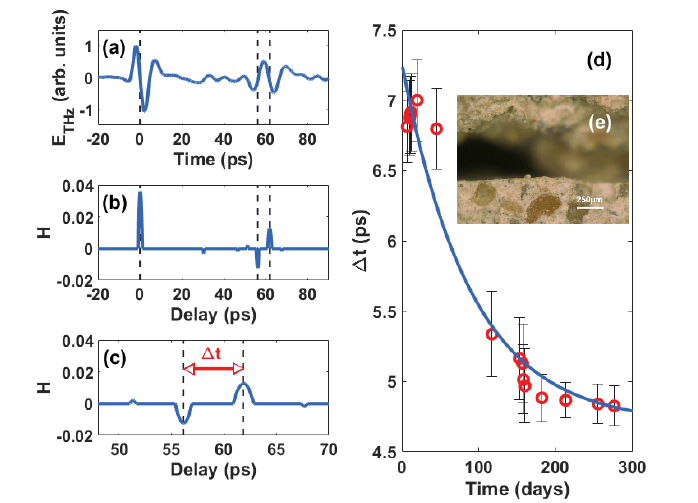
Figure 7. Measurements on a mockup sample. ( a ) Electric field time-domain signal as function of the delay, the vertical dashed lines show the positions where ecoes were found by using the deconvolved data. ( b ) Impulse function obtained from sparse deconvolution of the time-domain signal, the vertical dashed lines are provided in order to identify the main features that correspond to the air-mortar reflection, mortar-gap and gap-mortar interfaces. ( c ) is a closeup of the data in ( b ) in the 45 to 70 ps window, in which the parameter δ t that corresponds to the delay between the two interfaces around the gap is indicated. ( d ) The evolution of the temporal separation δ t between the peaks. The evolution is caused by the sublimation of the cyclododecane layer. ( e ) The micrograph of cross-section of one of the mock-ups showing that the cyclododecane layer disappeared after